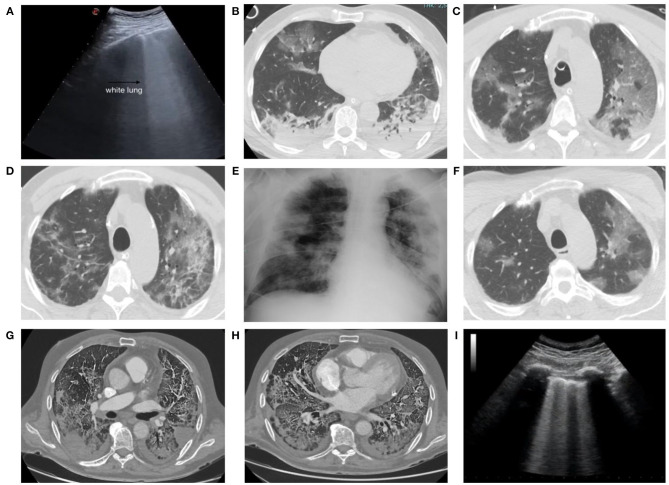
A 55-year-old man admitted to our emergency department with signs and symptoms of respiratory infection underwent chest ultrasound (US) (A), showing white lung areas, then confirmed at computed tomography (CT) examination (B) which showed multiple bilateral subpleural areas of ground glass opacity (GGO) in the upper lobes. CT scans obtained 48 h after admission showed the multiple GGO areas increased in number and extension (C) and the development of pulmonary consolidations in the basal posterior and lateral segments of both lower lobes (D). Chest x-ray obtained 9 days after admission (E) showed multiple coalescent pulmonary consolidations involving both lungs, mainly in the periphery. CT scans obtained 13 days after admission showed the GGOs in the upper lobes now partly regressed (F). CT scan in a 75-year-old man, with severe lung involvement, secondary to SARS-CoV-2 infection, showing pulmonary thromboembolic disease involving segmental arteries in the left (G) and right (H) lower lobes with triangular shaped subpleural consolidations (pulmonary infarcts). A 68-year-old man admitted to our emergency department with signs and symptoms of respiratory infection then resulted Covid+. Chest US showed an interstitial syndrome, characterized by more than three B lines per longitudinal field (I).